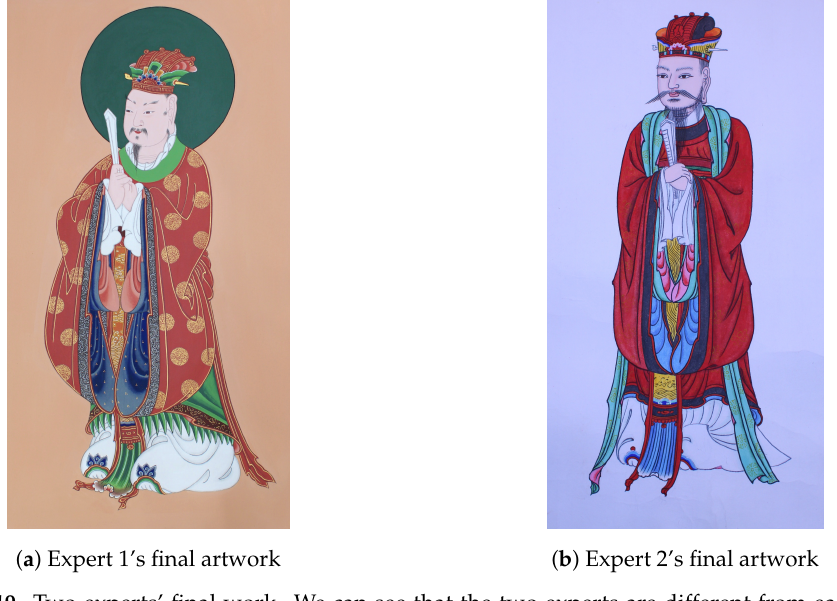
Figure 19. Two experts’ final work. We can see that the two experts are different from each other in style.